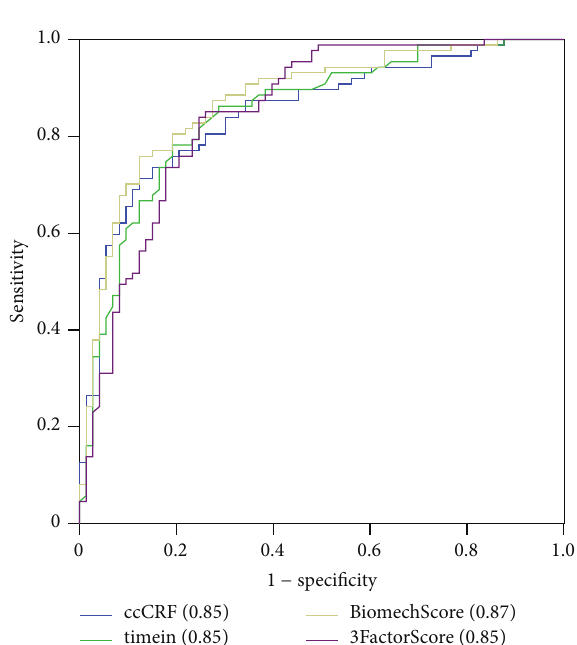
Figure 1: Comparative diagnostic capacity of corneal biomechan- ical indices. Receiver-operating characteristic curves are plotted for central-corneal-thickness-corrected corneal resistance factor (ccCRF), timein, a combined index that includes ccCRF (Biomech- Score), and the combination of the three extracted factors (3Fac- torScore). See Methods for details on each index. Area under the curve is specified in parentheses for each